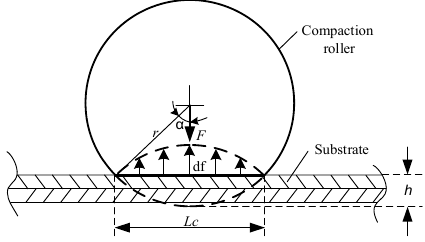
Figure 2. The contact area between the compaction roller and the